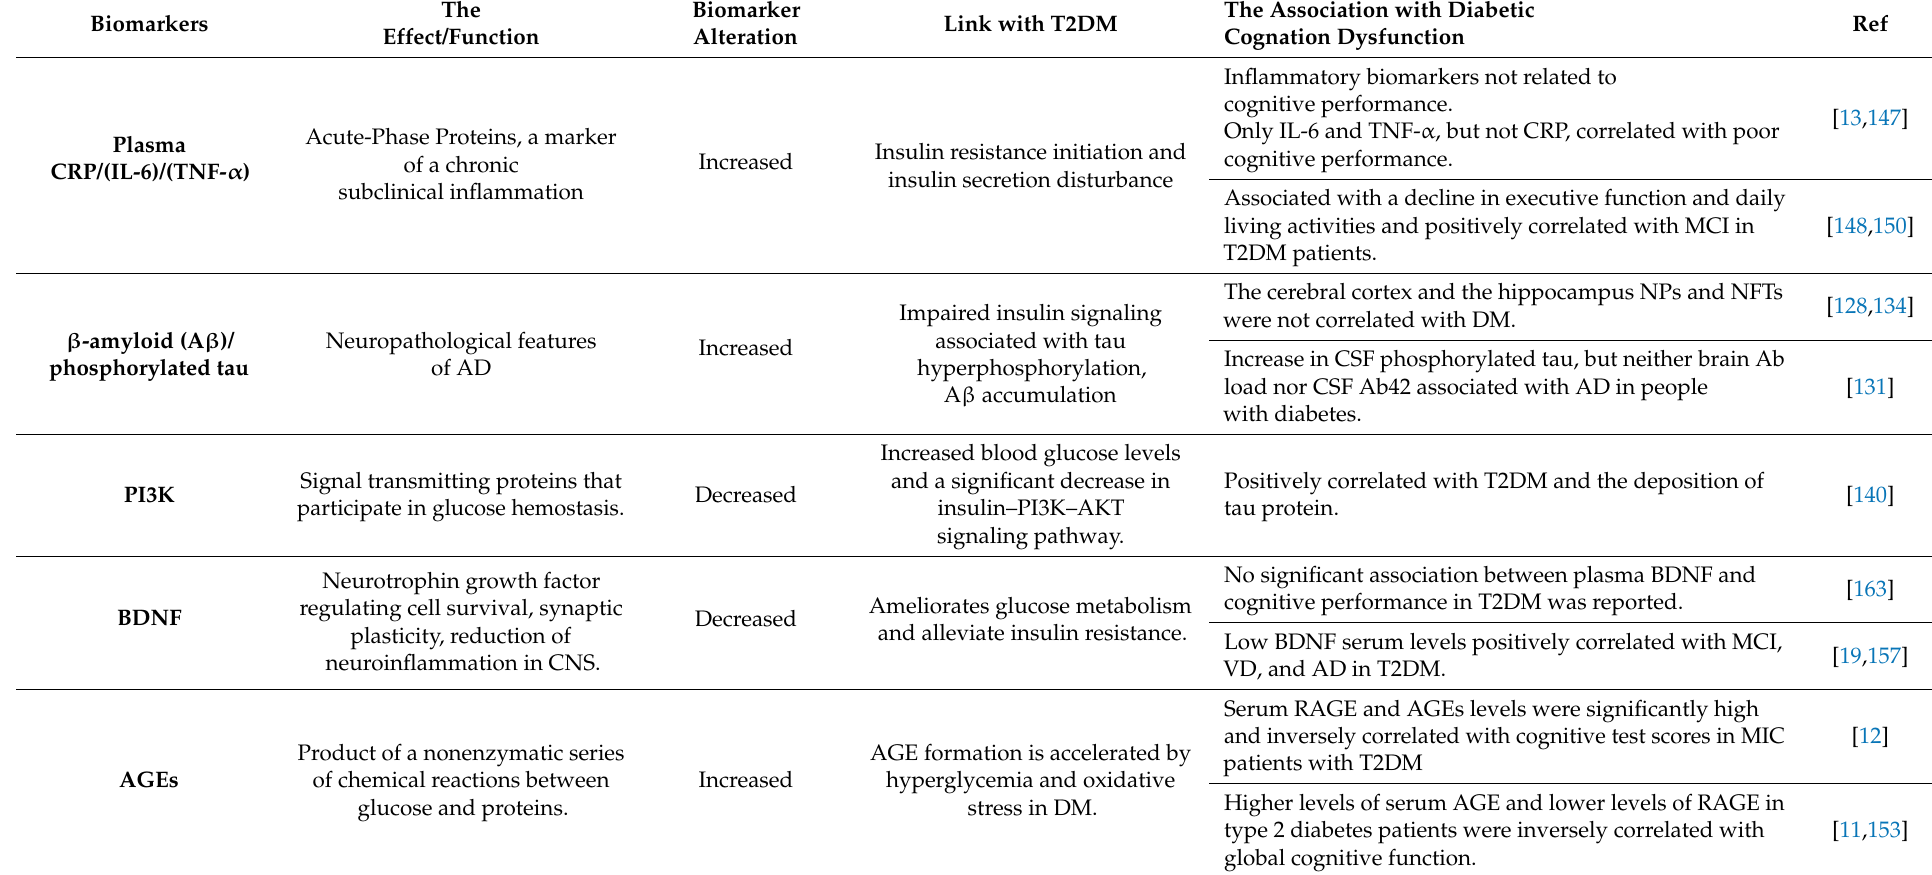
Table 3. Summary of the biomarkers of diabetes-related cognitive dysfunction discussed in this